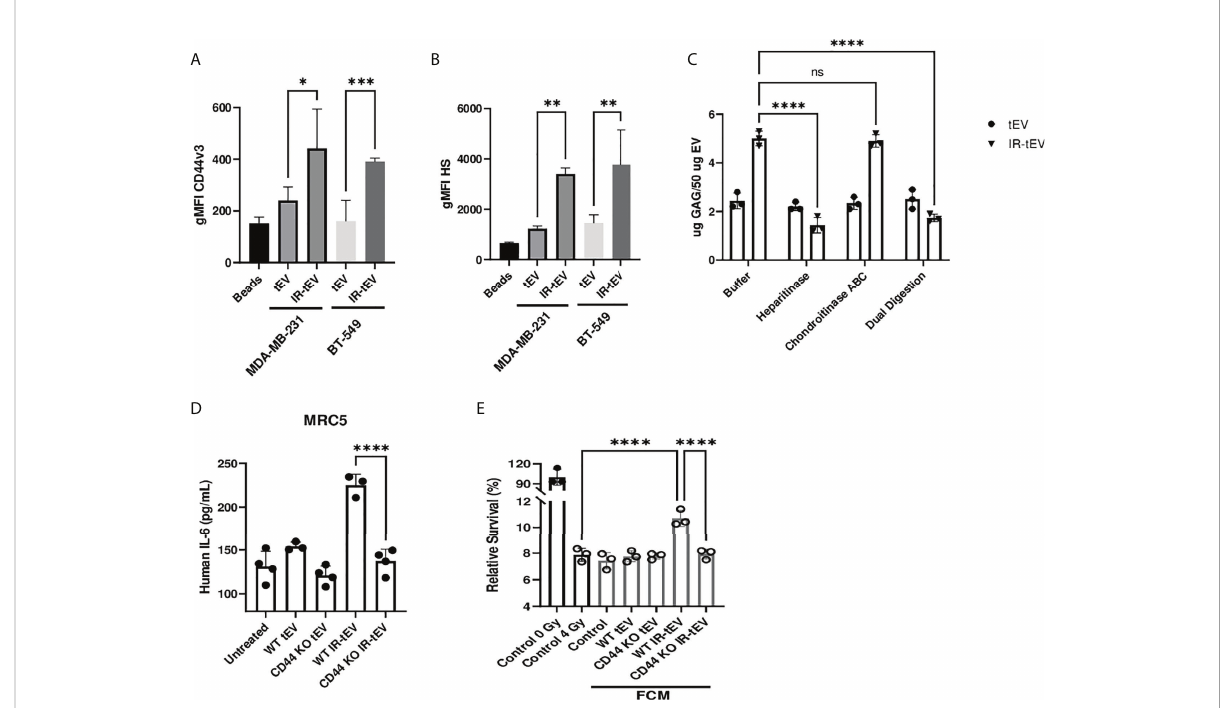
FIGURE 2 Radiation stimulates vesicular CD44v3 expression. (A, B) tEVs from breast cancer cells were assessed for CD44v3 (A) and HS (B) expression via fl ow cytometry. Control represents unbound beads incubated with antibody cocktail. (C) tEVs from MDA-MB-231 cells were treated overnight with either heparanase, chondroitinase ABC, or both. Gag levels were assessed via blyscan assay. Data points represent technical replicates. (D) MRC5 were incubated with tEVs collected from WT or CD44 KO MDA-MB-231. IL-6 levels were measured via ELISA. (E) MDA-MB-231 were exposed to fresh media containing FCM described in (D) and radioresistance was assessed via clonogenic assay. X axis indicates which fi broblast CM from (D) was used in the incubation. Statistical signi fi cance for (A-E) assessed with ANOVA * = P < 0.05. (D, E) Data points